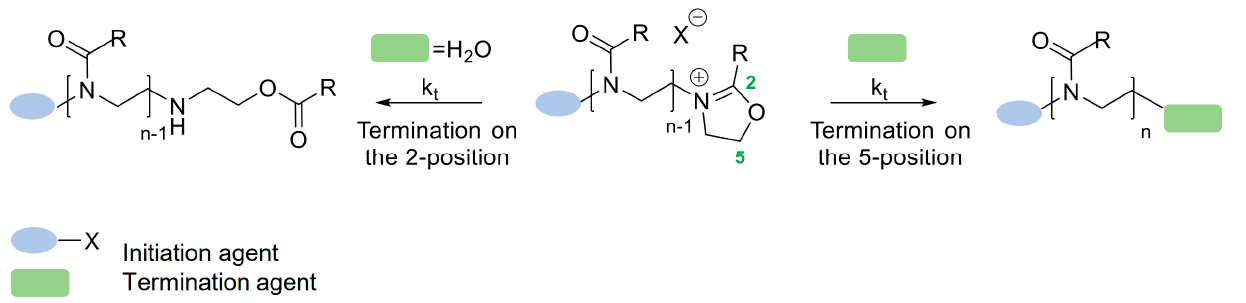
Figure 7. The termination mechanisms of the living cationic ring-opening polymerization (CROP) of 2-oxazoline monomers. Adapted from [12].